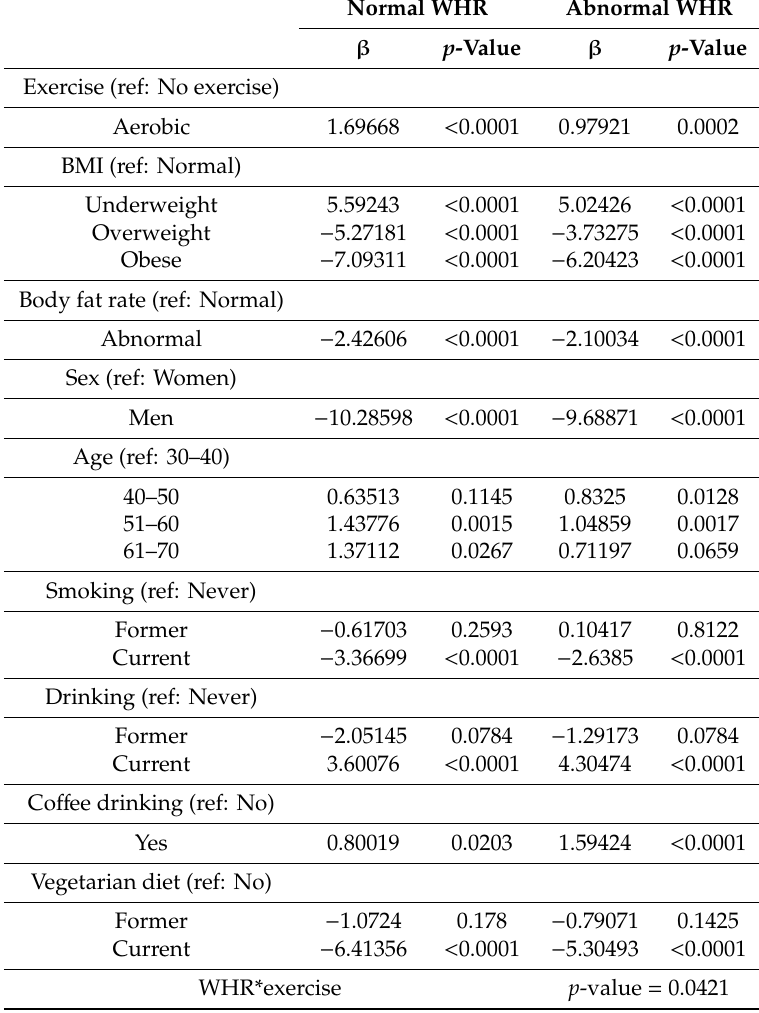
Table 4. Multiple linear regression showing the e ff ect of aerobic exercise on HDL-C based on WHR. Normal WHR Abnormal